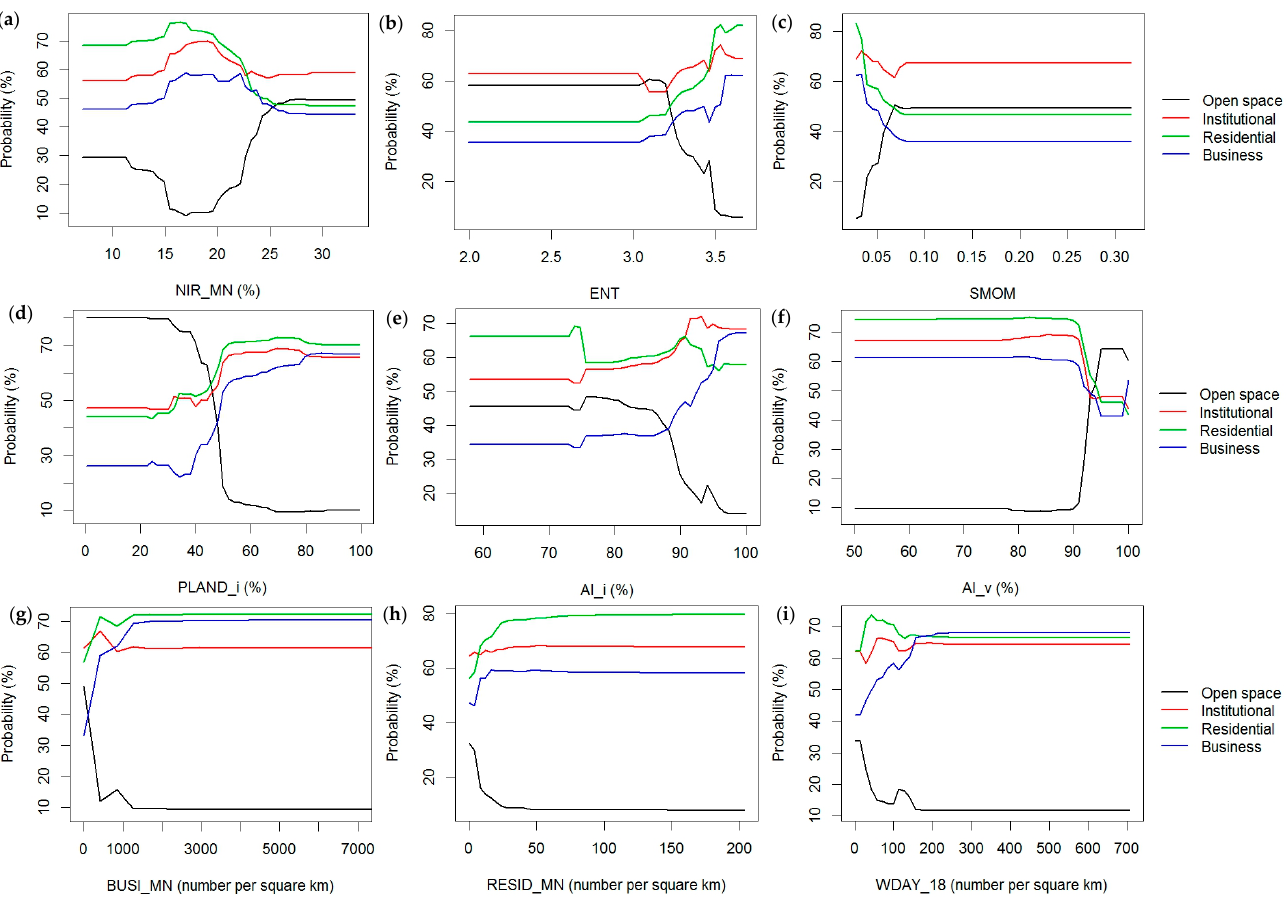
Figure 6. Partial dependence plots of the three most important attributes for the classification of different land use types: NIR_MN ( a ), ENT ( b ), SMOM ( c ), PLAND_i